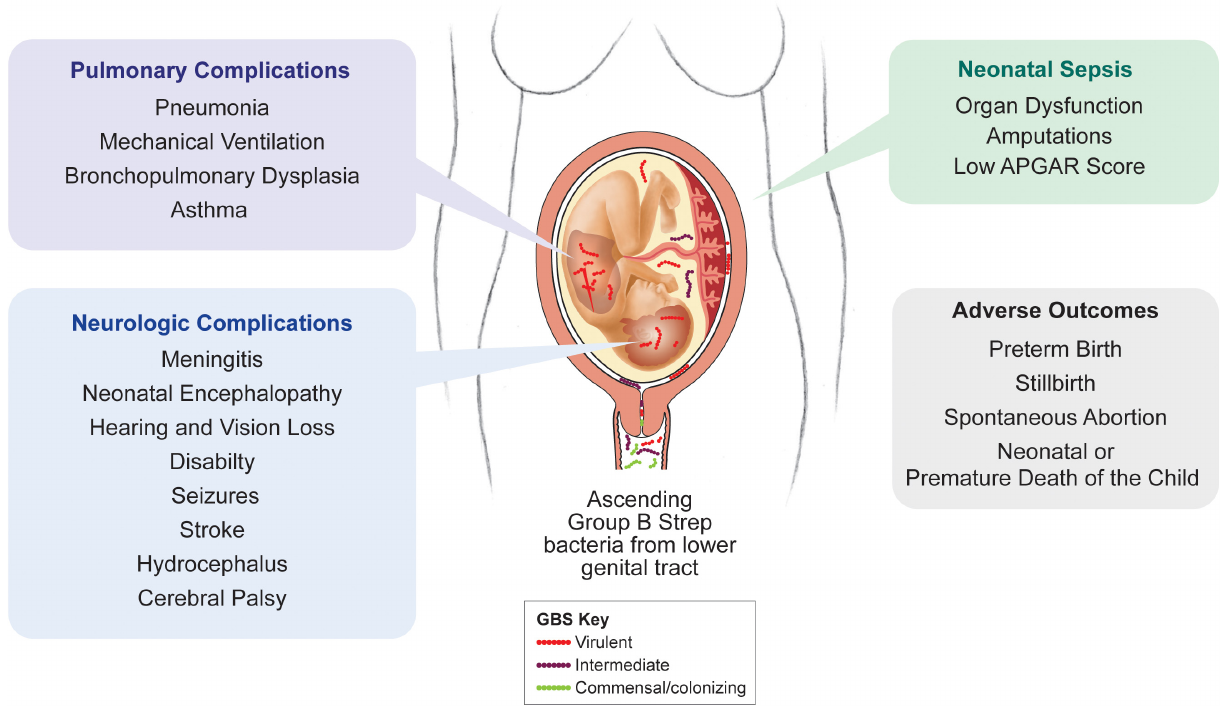
FIGURE 4 | Clinical outcomes of invasive GBS infection. In humans, invasive GBS infections can result in a spectrum of obstetrical and neonatal systemic, pulmonary, and neurological complications. The majority of these complications are also observed in the NHP